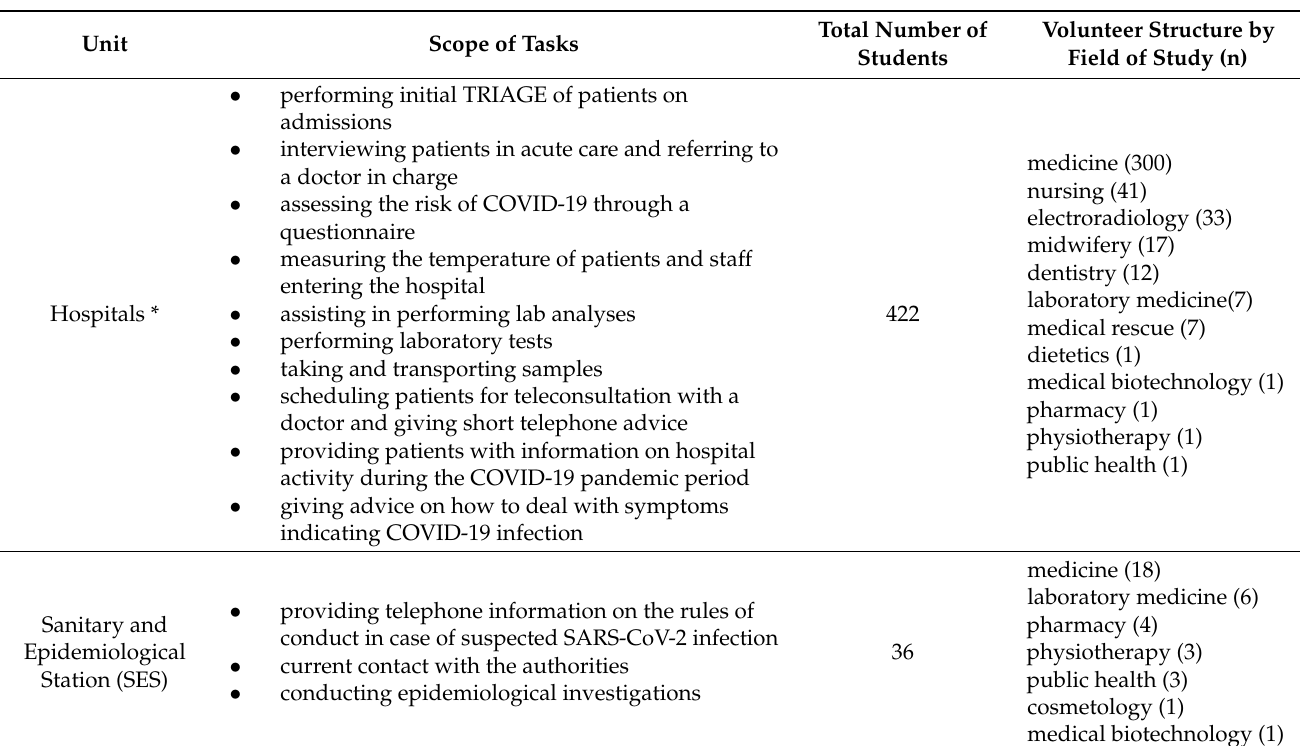
Figure 1. Stages of the development and implementation of the volunteering service project. Table 1. Participation of Poznan University of Medical Sciences student volunteers in various units and the scope of the entrusted tasks (as of 19 May